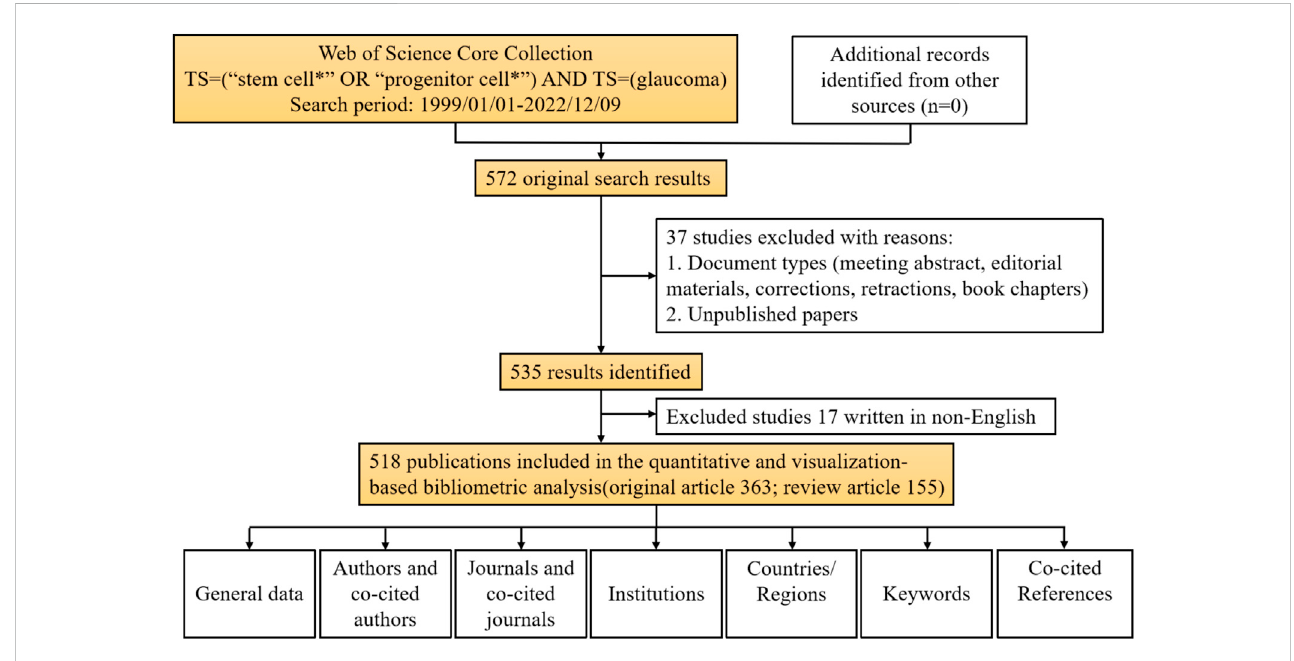
FIGURE 1 Data screening fl ow chart and steps of bibliometric analysis. The literature search was performed on the Web of Science Core